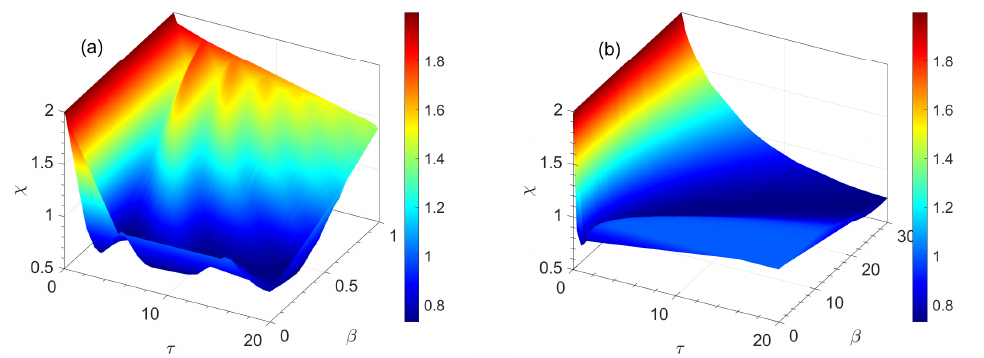
Figure 6. Dense coding capacity in terms of the scaled time τ = γ 0 t and Stark shift parameter β for ( a ) non-Markovian λ = 0.1 γ 0 and ( b ) Markovian λ = 10 γ 0 regimes with µ = 1/